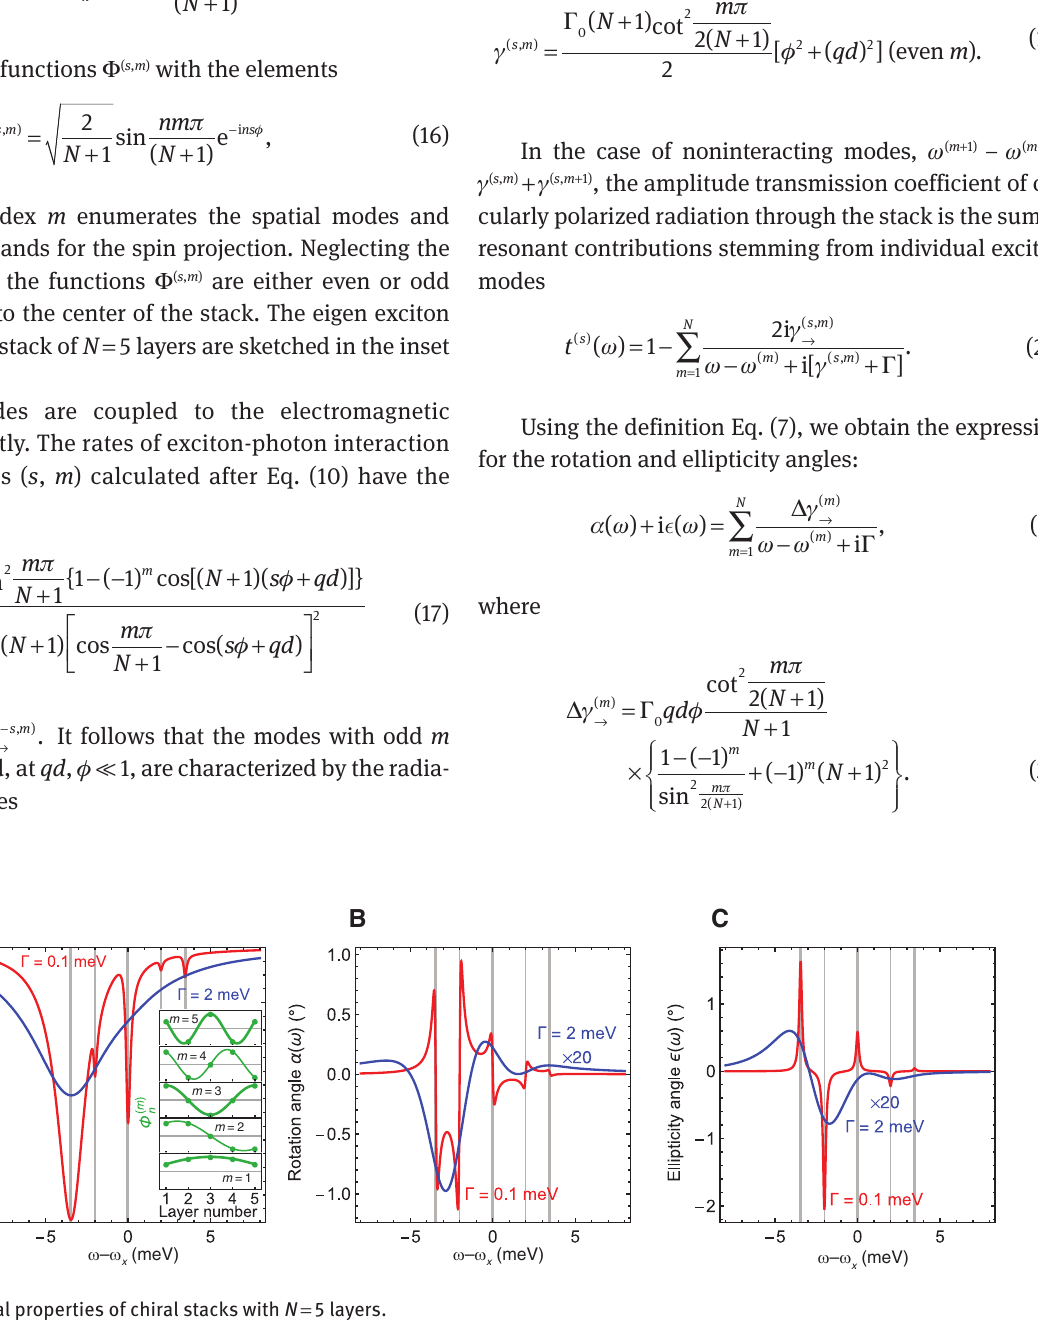
Figure 3: Optical properties of chiral stacks with N = 5 layers. (A) Transmittance | t ( ω ) | 2 , (B) polarization rotation angle α ( ω ), and (C) ellipticity angle ε ( ω ). Vertical lines indicate the frequencies of eigen exciton modes. Inset in Figure 3A shows the distributions of the exciton polarization over the layers for the eigenmodes. Red and blue curves are calculated for the stacks with low and high nonradiative decay rates of excitons, respectively. Parameters are the same as for Figure